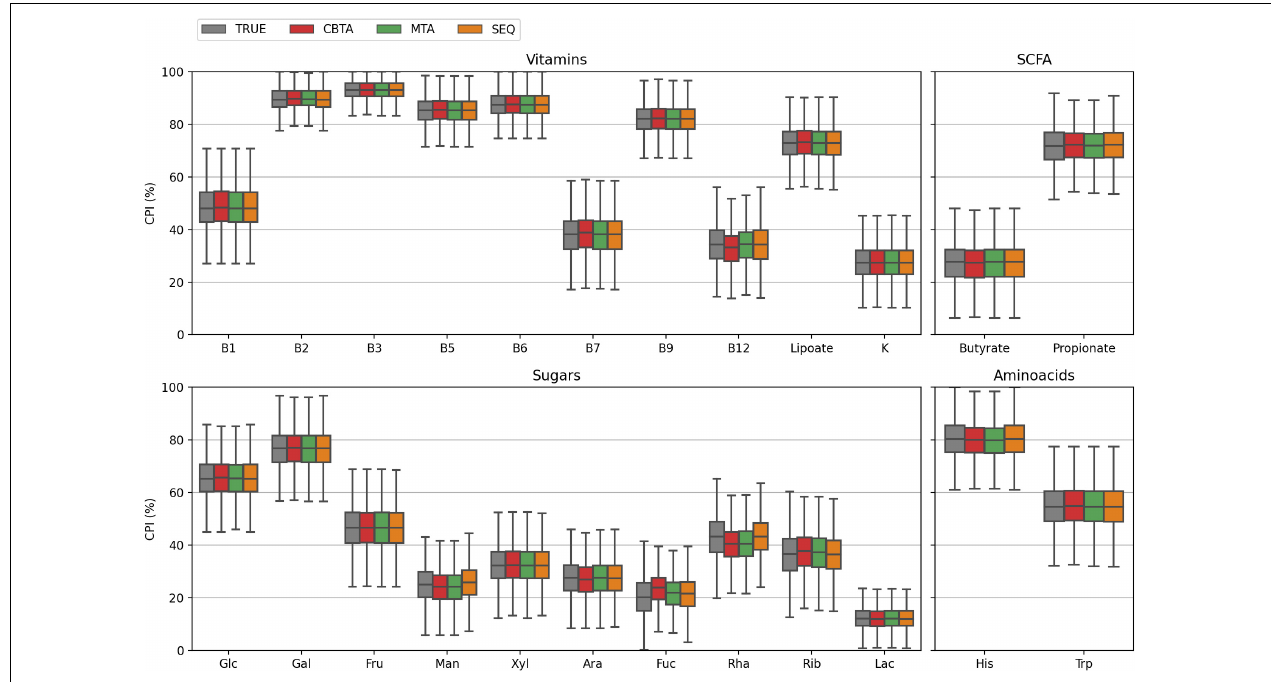
FIGURE 2 | CPI value distributions for 1,000 in silico generated mock communities. Phenotype Indices (PI) are predicted according to four ASV-to-BPM mapping schemes: (i) TRUE, with true Pis; (ii) CBTA and MTA, with PIs predicted using taxonomy-based mapping schemes; (iii) SEQ, with PIs predicted using a sequence-based mapping